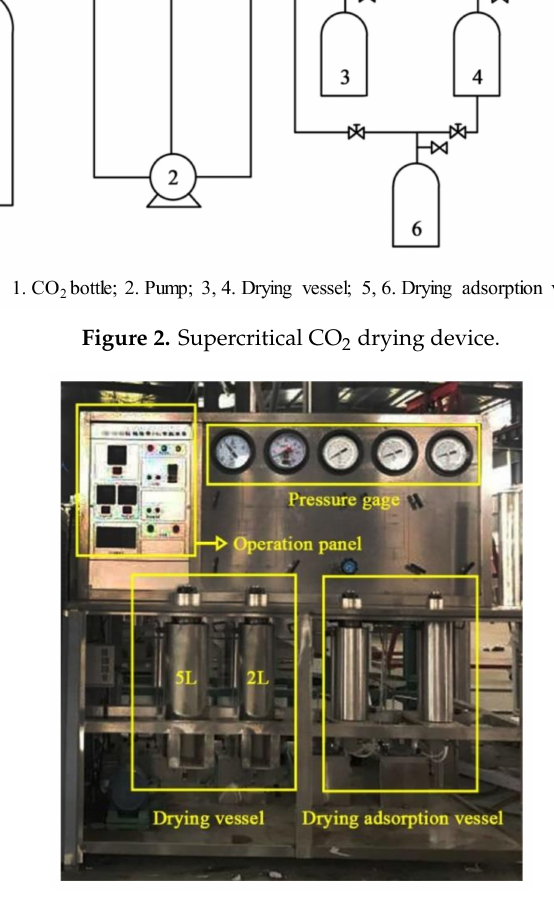
Figure 3. Photo of a part of the supercritical CO 2 drying